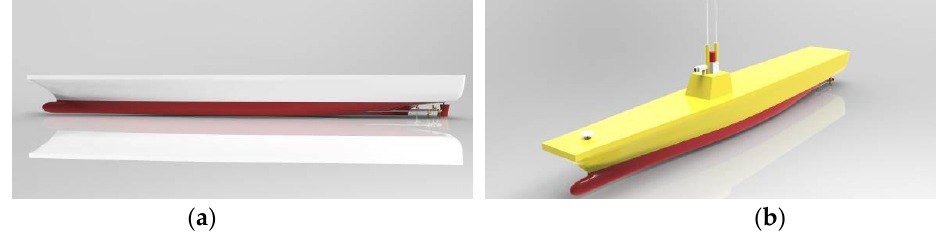
Figure 1. Conceptual view of the models: ( a ) the small-scale model; and ( b ) the large-scale model. Table 1. Main particulars.